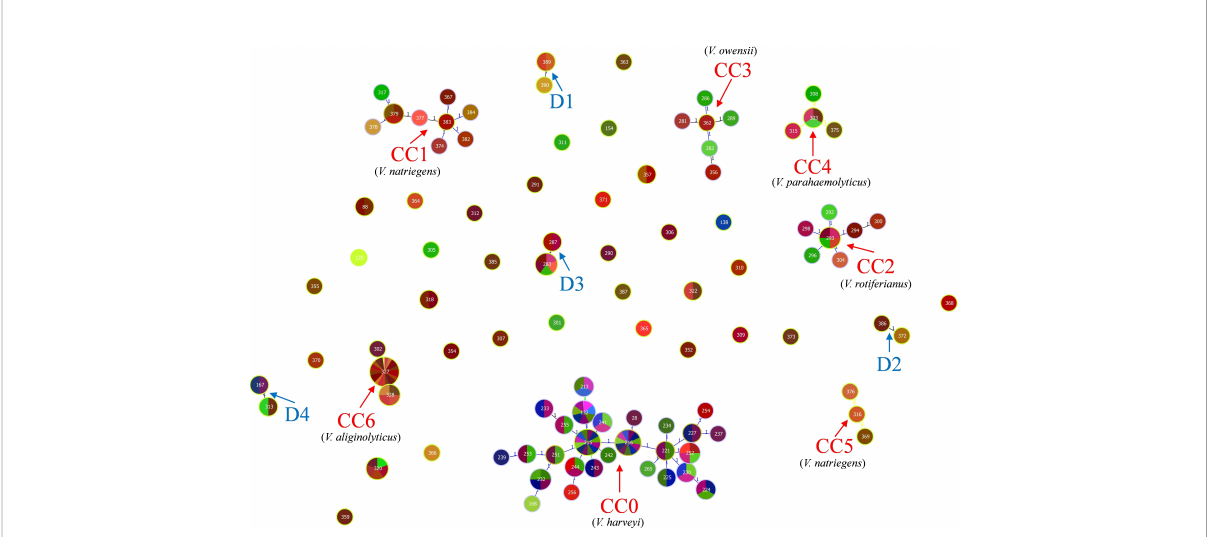
FIGURE 3 goeBURST minimum spanning tree for all the 95 sequence types obtained from the combination of all allele types of the four MLST loci gyrB , pyrH , recA , and atpA using the PHYLOViZ 2.0 analysis software. The genetic relationships between all the analyzed Chinese Harvey i clade isolates are indicated. Note: The different numbers in the circles represent different